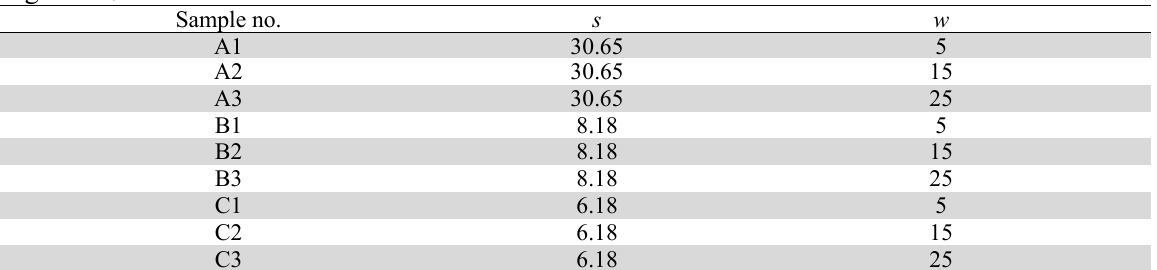
Taguchi L 9 DOE for MMC fabrication Sample no. s